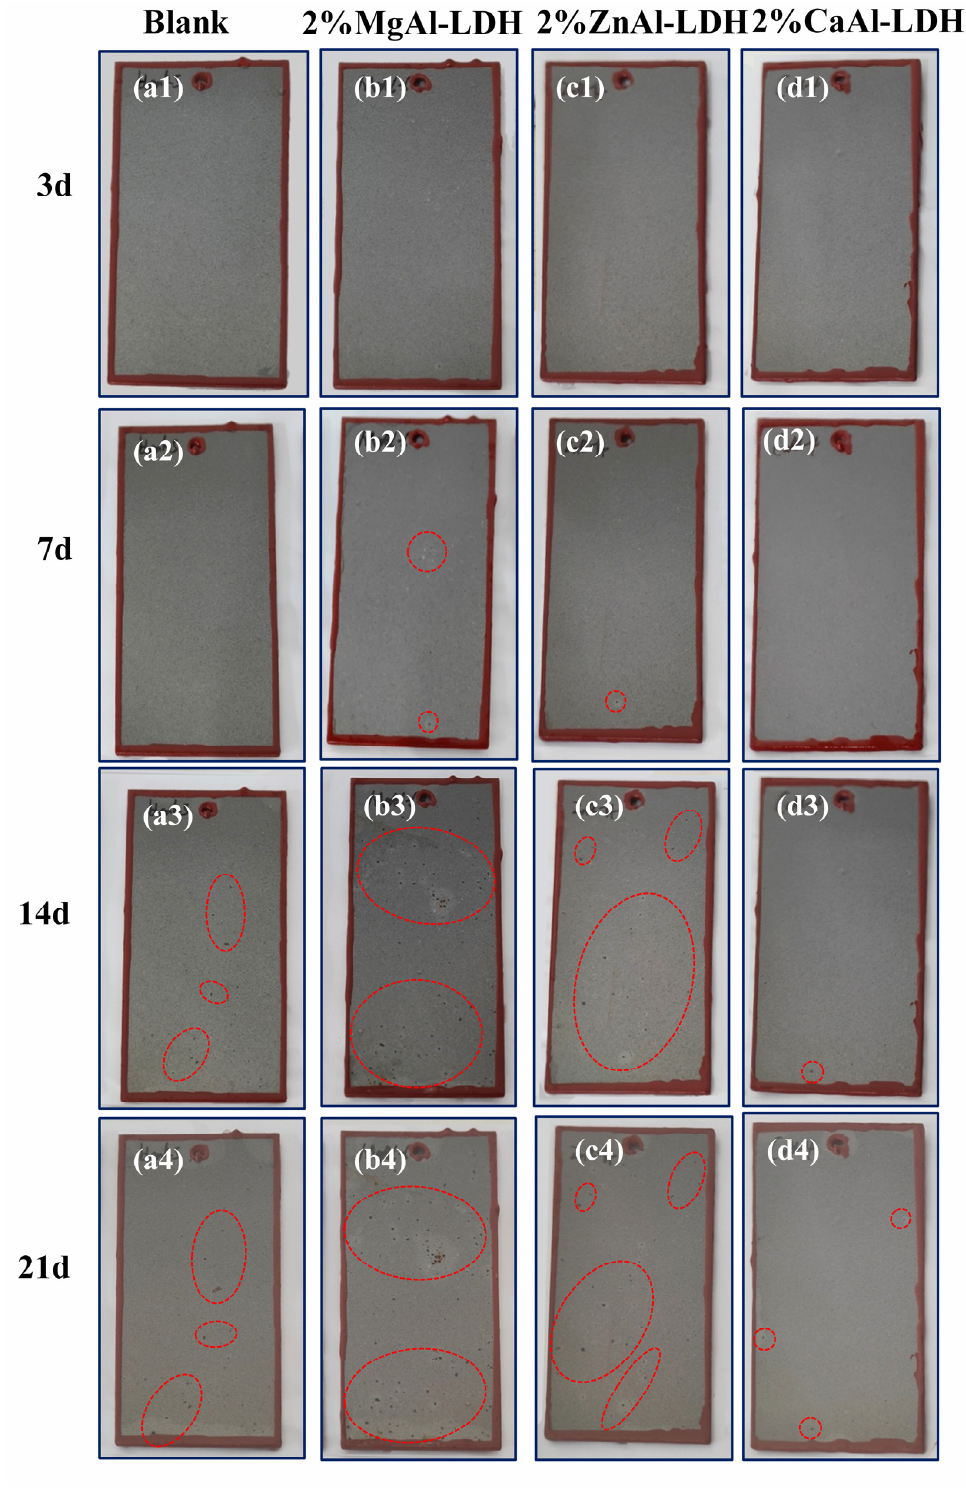
Figure 19. The optical images of different coating samples after exposure for various time ( a1 – a4 ). The sample with blank epoxy coatings at 3 d, 7 d, 14 d and 21 d; ( b1 – b4 ) The sample with epoxy coatings containing 2% MgAl-LDH at 3 d, 7 d, 14 d and 21 d; ( c1 – c4 ) The sample with epoxy coatings containing 2% ZnAl-LDH at 3 d, 7 d, 14 d and 21 d; ( d1 – d4 ) The sample with epoxy coatings containing 2% CaAl-LDH at 3 d, 7 d, 14 d and 21